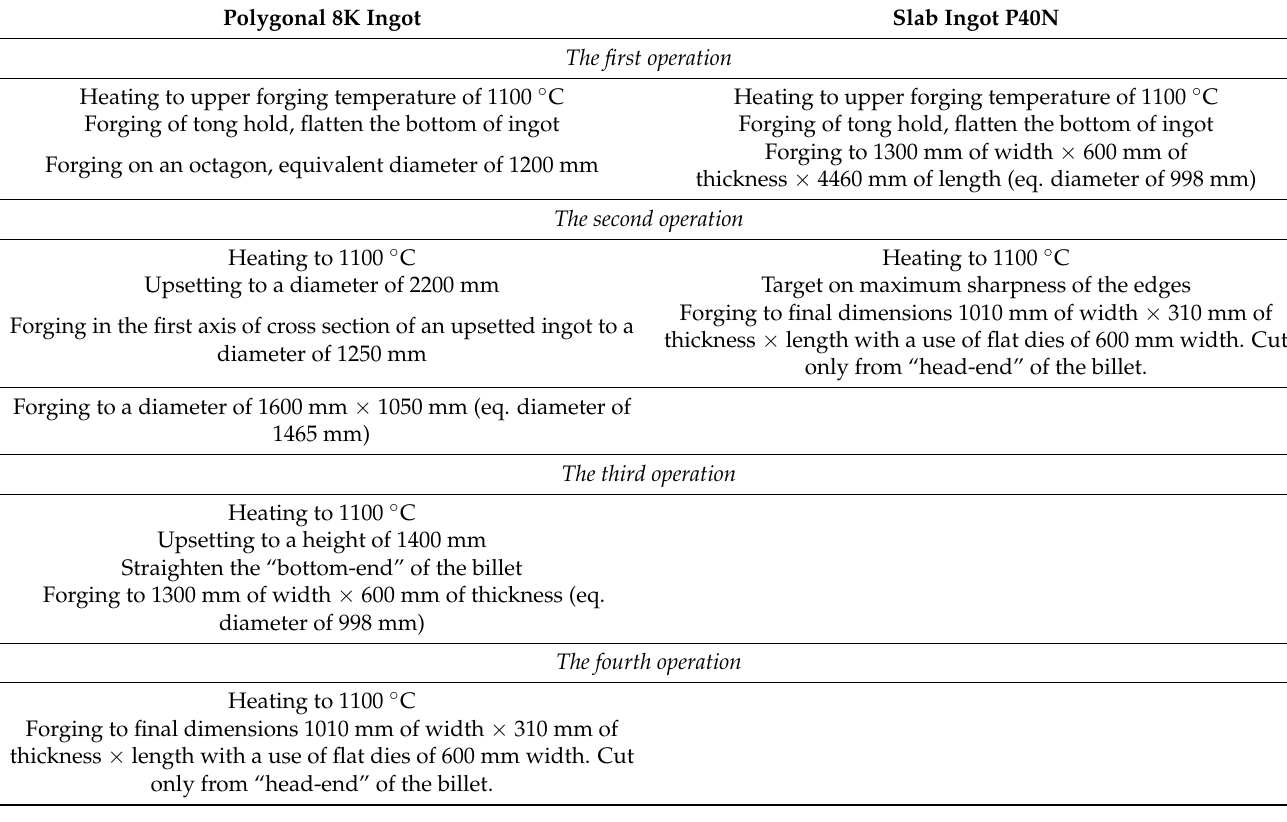
Figure 2. The dependence of flow stress (SIG) of the 55NiCrMoV7 material model on effective plastic strain (EPS) at temperatures 800 ◦ C (green curve), 1000 ◦ C (blue curve), 1200 ◦ C (red curve), at . ε = 1. constant strain rate Table 3. The forging procedure of an 8K polygonal ingot and a P40N slab